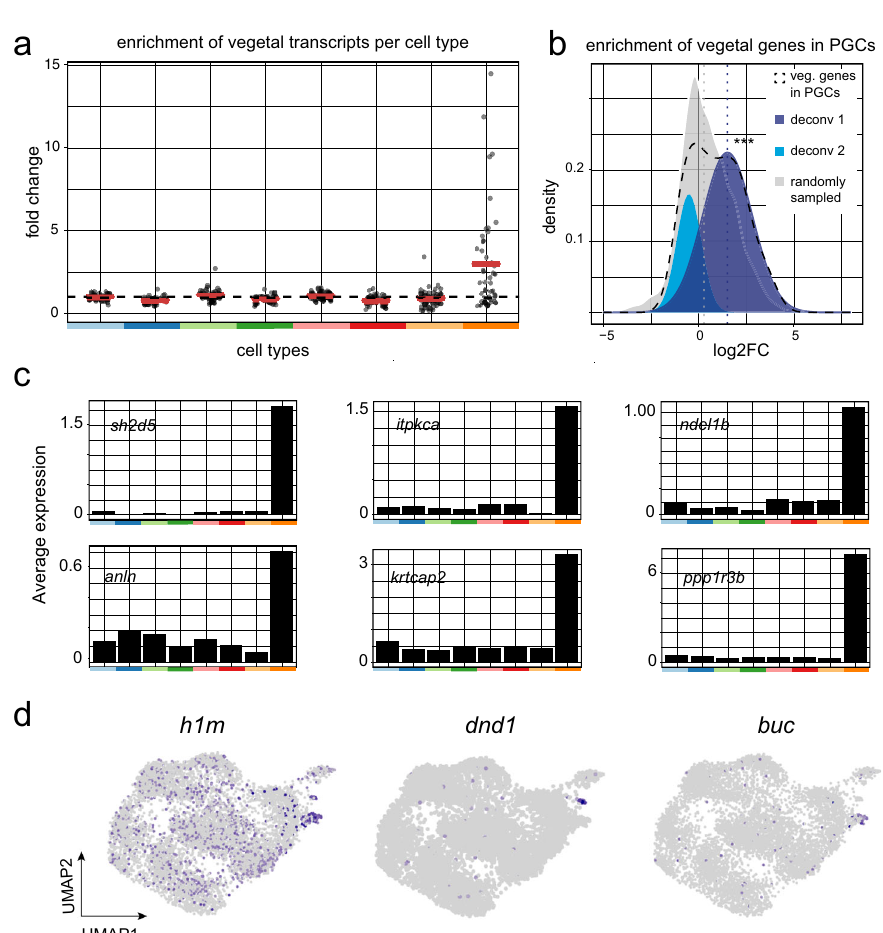
Fig. 4 Tracking the fate of maternal transcripts by scSLAM-seq. a Fold change enrichment of maternal vegetally localized genes in the different cell types versus all other cells (color code as in Fig. 3d). Genes with an average expression <0.1 transcripts/cell were excluded from this analysis. Red bars represent mean values. b Deconvolution of the bimodal distribution of vegetally localized genes in PGCs (black dashed line) into two normal distributions (light and dark blue). The mean value of the dark blue distribution is signi fi cantly higher than that of a randomly sampled distribution ( m gray = 0.4, m dark blue = 1.52, p value = 1.7 × 10 − 4 , Welch ’ s t test, one-sided). c Average expression of most highly enriched genes in PGCs in different cell types (color code as in Fig. 3d). d Unlabeled RNA expression of established germ cell markers on a UMAP